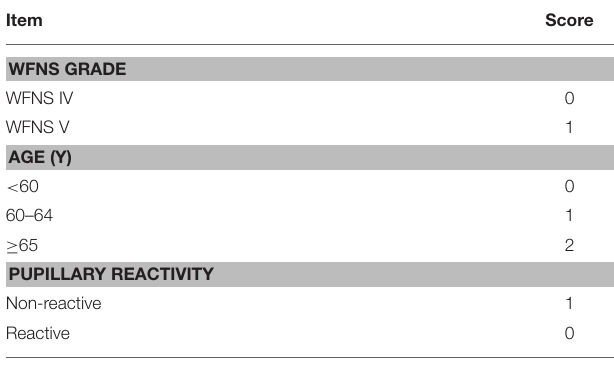
TABLE 3 | WAP score components and weightings.